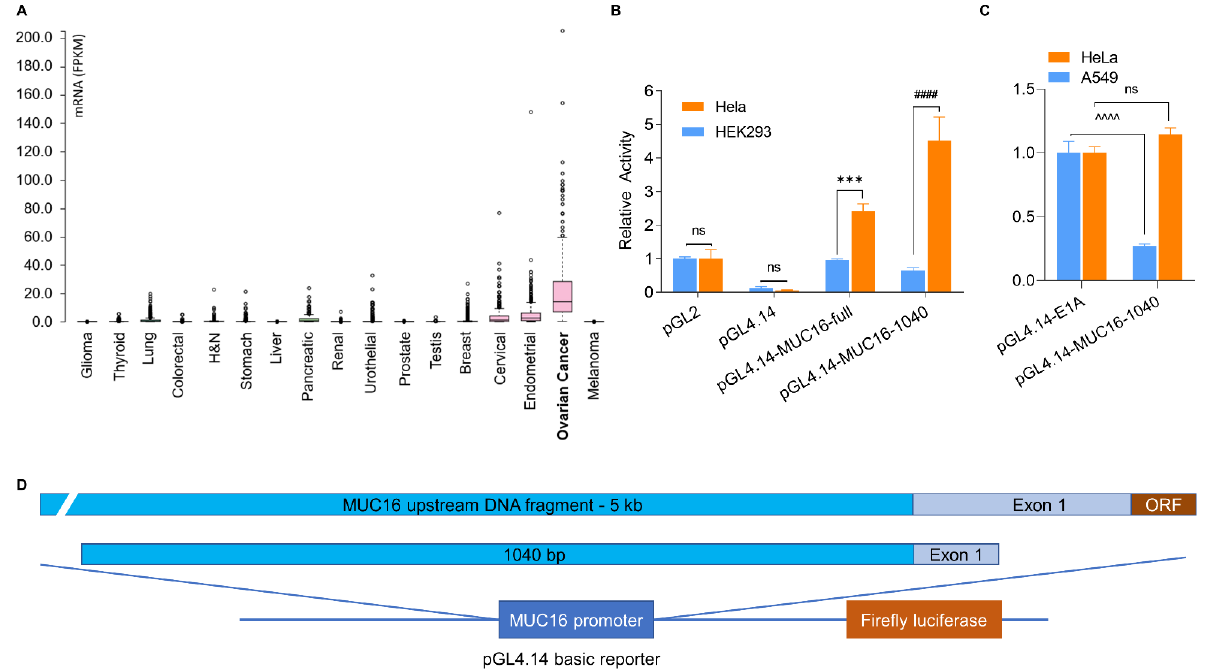
Figure 1. Identification of specific transcription of MUC16 . ( A ). CA-125 mRNA expression in human cancers (TCGA database). ( B ). Relative activity of MUC16 upstream fragment in HEK293 cells (CA-125-low) and HeLa cells (CA-125-high), compared to the pGL-2 reporter. ( C ). Relative activity of MUC16 fragments in A549 cells (CA-125-low) and HeLa cells, compared to the Ad5/E1A promoter. ( D ). Illustration of MUC16 upstream fragments and construction of firefly luciferase reporter. *** p = 0.0002 pGL4.14-MUC16-full: HeLa vs. pGL4.14-MUC16-full: HEK293, #### p < 0.0001 pGL4.14-MUC16-1040: HeLa vs. pGL4.14-MUC16-1040: HEK293, ˆˆˆˆ p < 0.0001 pGL4.14-E1A: A549 vs. pGL4.14-MUC16-1040: A549, ns, no statistical significance, n =